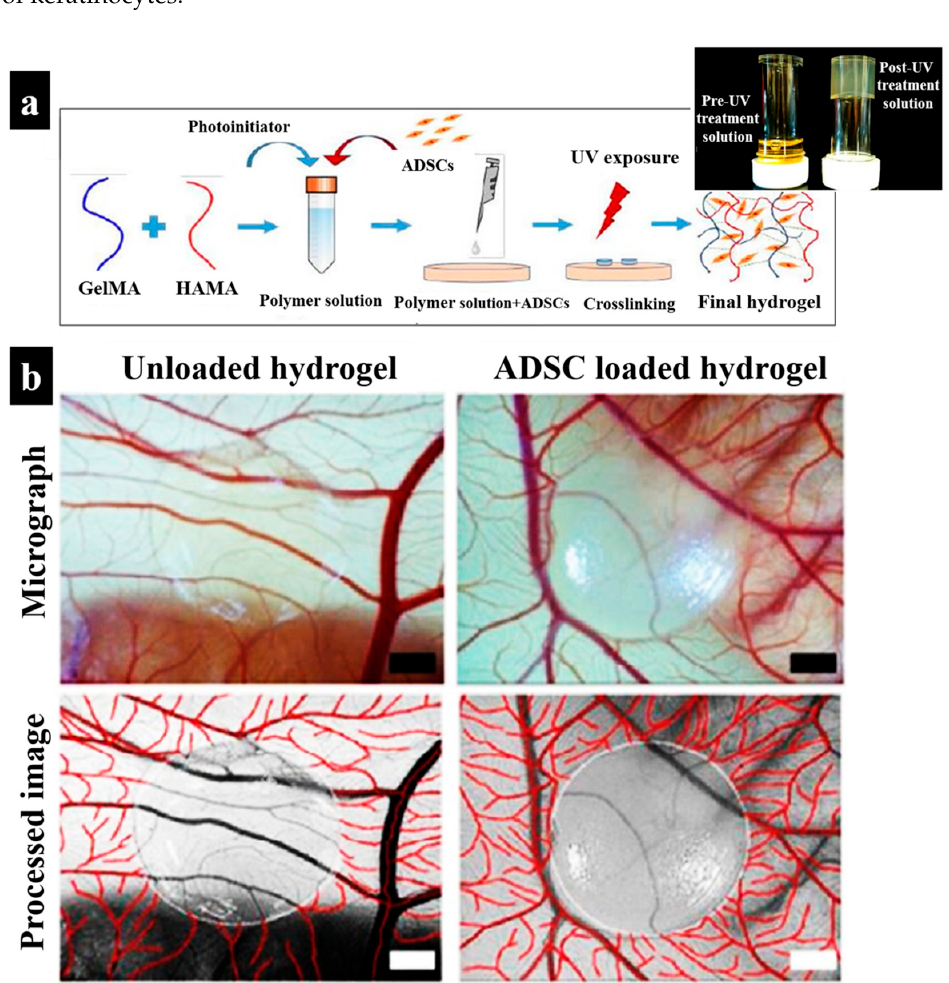
Figure 4. ( a ) Schematic demonstrating methacrylated gelatin (GelMA) acid methacrylated hyaluronic acid (HAMA) chain integration to prepare polymer solution. Furthermore, the addition of a photoinitiator to prepare a UV-crosslinkable hydrogel containing adipose-derived stem cells (ADSCs) to produce a cell-laden hydrogel wound dressing. Gel solution before (left picture) and after (right picture) 50 s of UV exposure. And ( b ) Angiogenic characteristics of the bicomponent network (BCN) hydrogel in the chick chorioallantoic membrane (CAM) test. Micrographs (upper pictures) and semi-automatic treated images (lower pictures) of the hydrogel and hydrogel-loaded ADSCs, taken on day 14 of embryonic development [98].